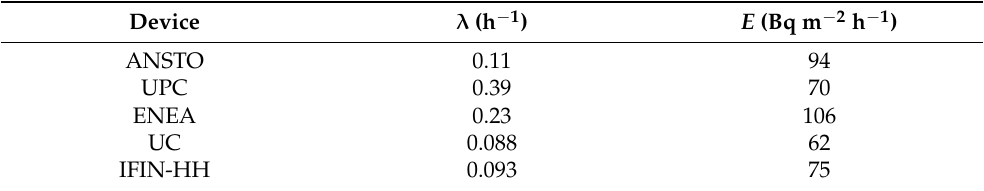
Table 6. Total leakages λ and radon flux E obtained from the exponential fit applied over a static accumulation experiment at the low radon flux area campaign.